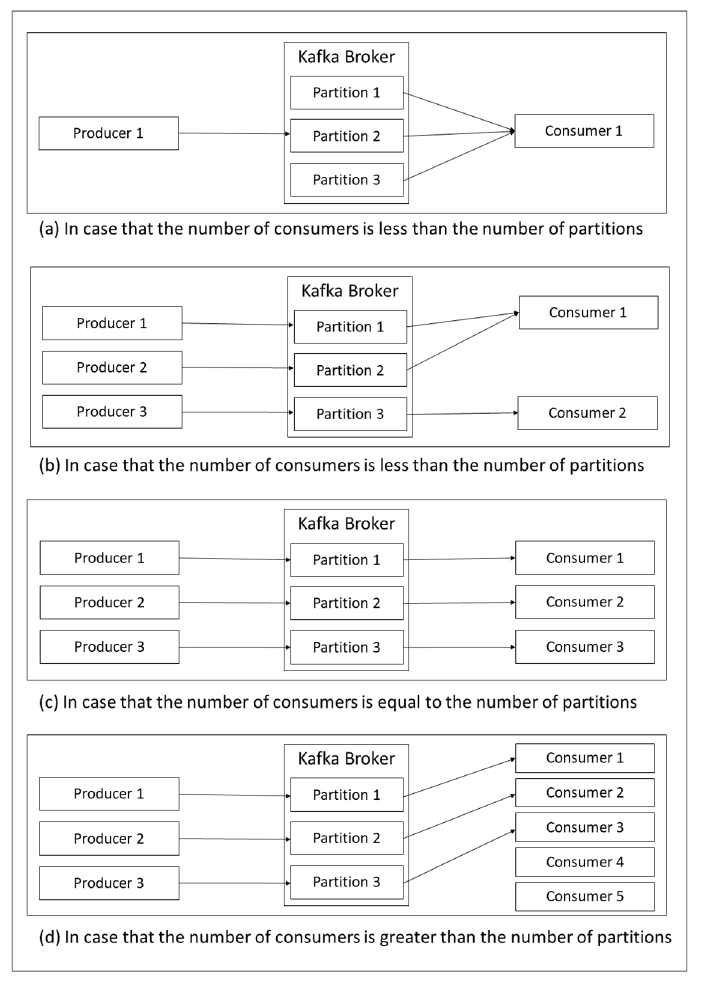
Figure 5. Partitioning in Kafka Consumer.